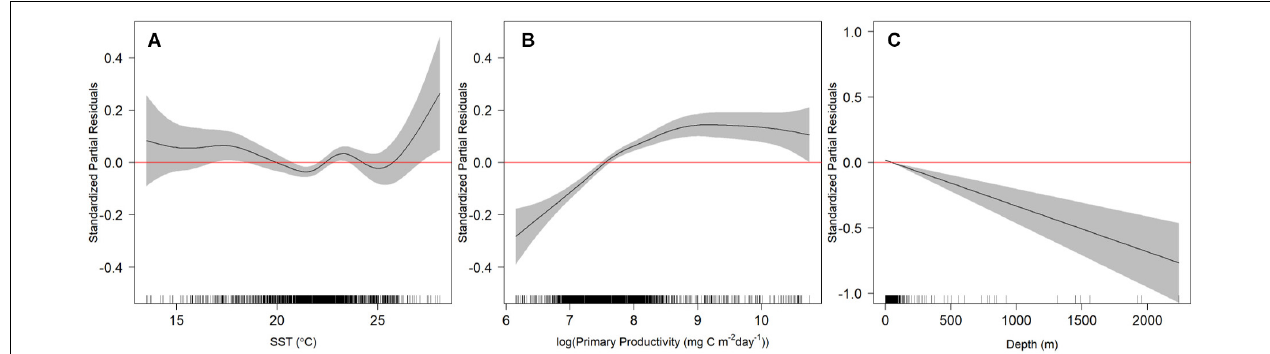
FIGURE 5 | Relationship of sea surface temperature (SST; A ), log of primary productivity (B) and seafloor depth (C) with resident behavior exhibited by juvenile smooth hammerhead sharks. Values with 95% confidence intervals that do not overlap with 0 (red line) indicate either increased (positive values) or decreased probability of resident behavior (negative values; transient behavior). Black ticks along the x-axis represent the distribution of the independent variable values examined. Note y-axis scales differ.